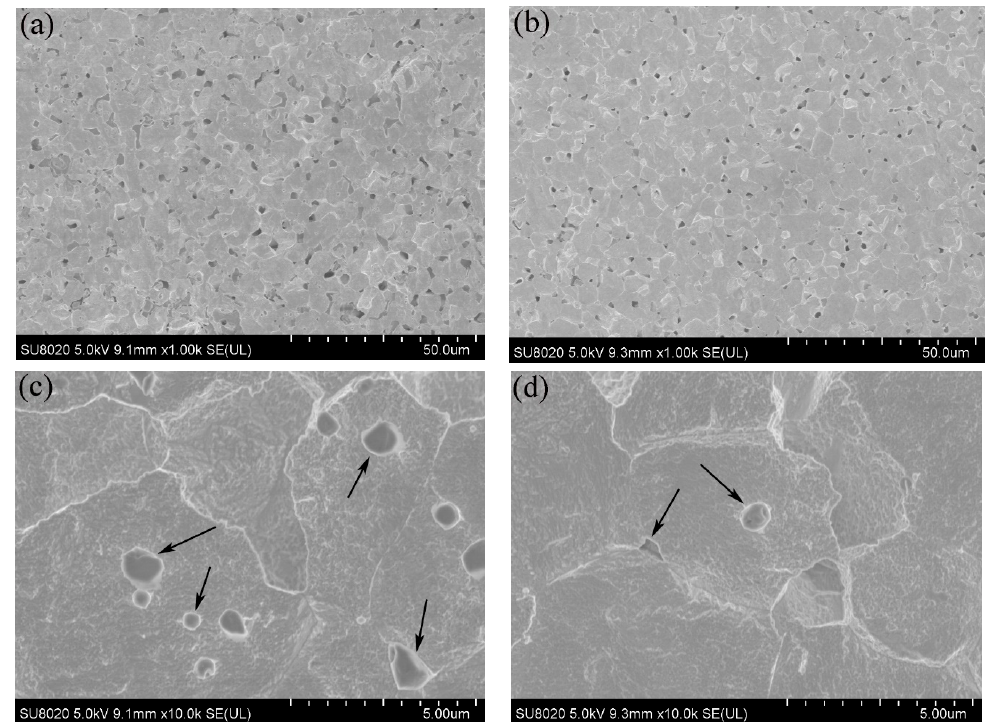
Figure 5. SEM micrographs of the polished and etched surfaces. ( a , c ) W–1 wt % Nd 2 O 3 ; ( b , d ) W–1 wt % CeO 2 .